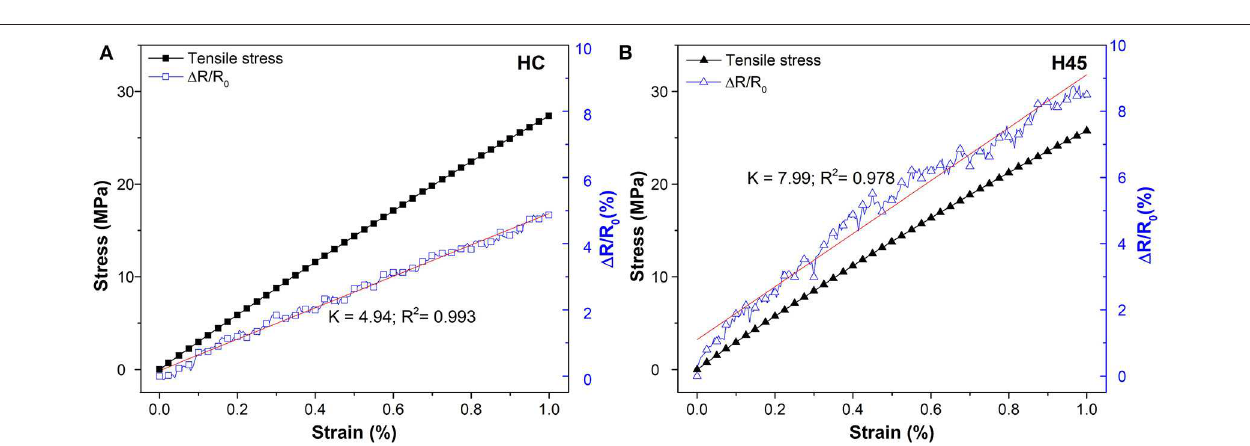
R 2 is reported). All single data with R 2 in the range